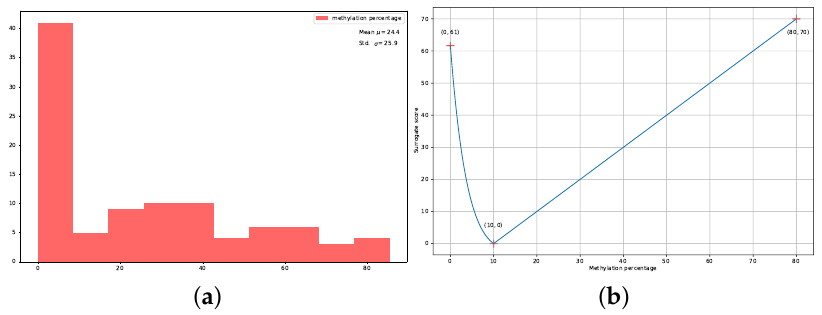
Figure A2. Methylation percentage distribution ( a ) and confidence metric function derived from methylation percentage ( b